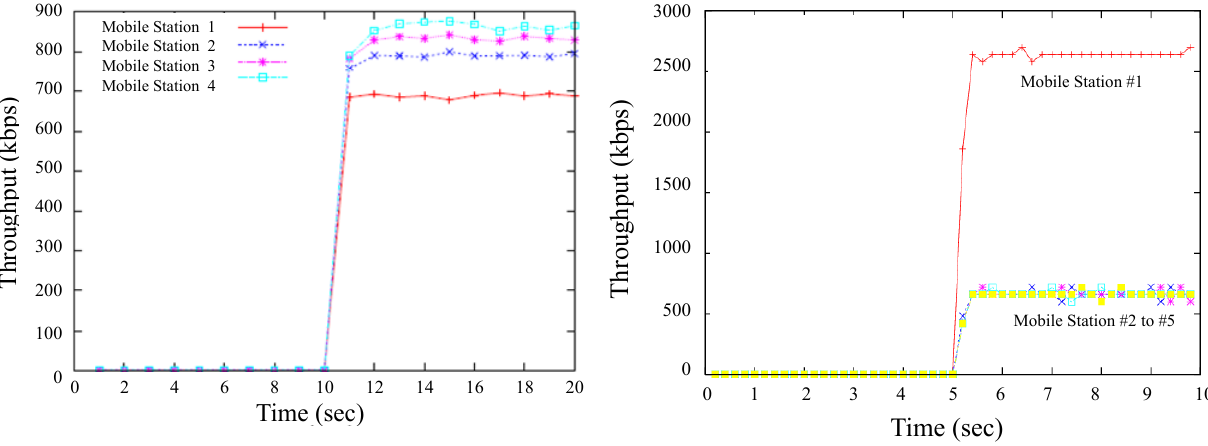
Figure 6. DRRF Throughput. a. (left) 4 flows: with GWF weight 0.5; b. (right) 5 flows: MS with 2Mbps r min